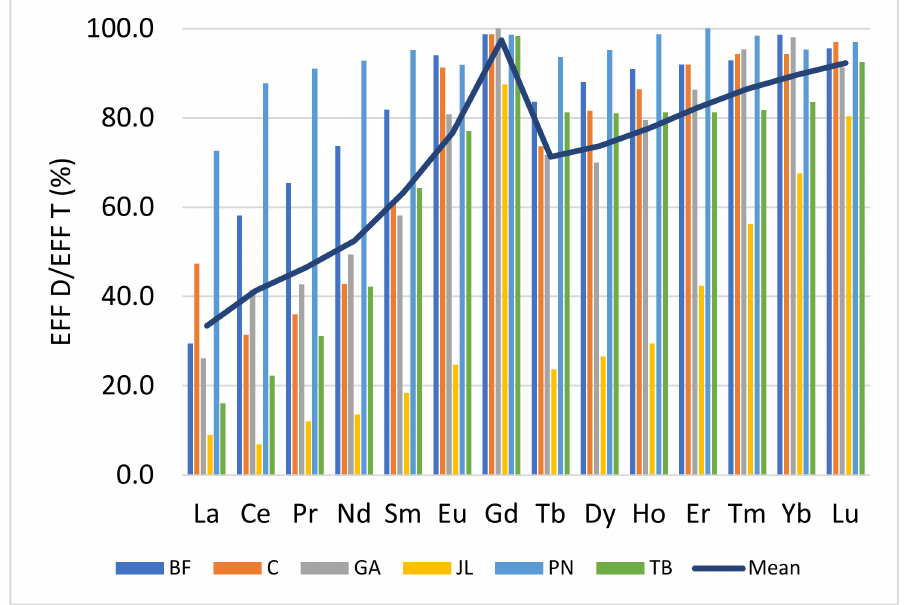
Figure 1. Dissolved proportion of lanthanides in effluents ( n = 3) from various municipalities in